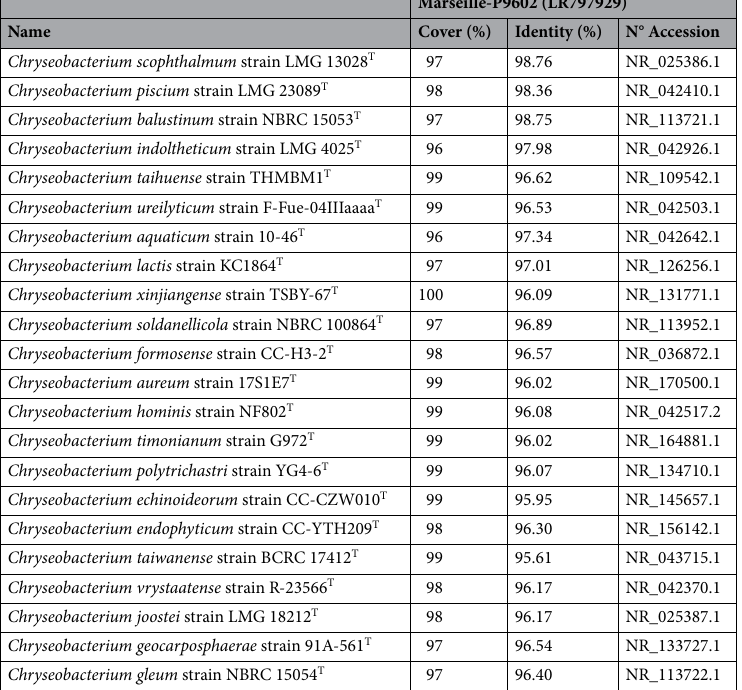
Table 1. The taxonomic assignment obtained by a BLASTn search in the nr database. Marseille-P9602 strain has a high sequence similarity, but a sequence cover lower 38 , with Chryseobacterium scophthalmum strain LMG 13028 T , Chryseobacterium piscium strain LMG 23089 T , Chryseobacterium balustinum strain NBRC 15053 T and Chryseobacterium indoltheticum strain LMG 4025 T